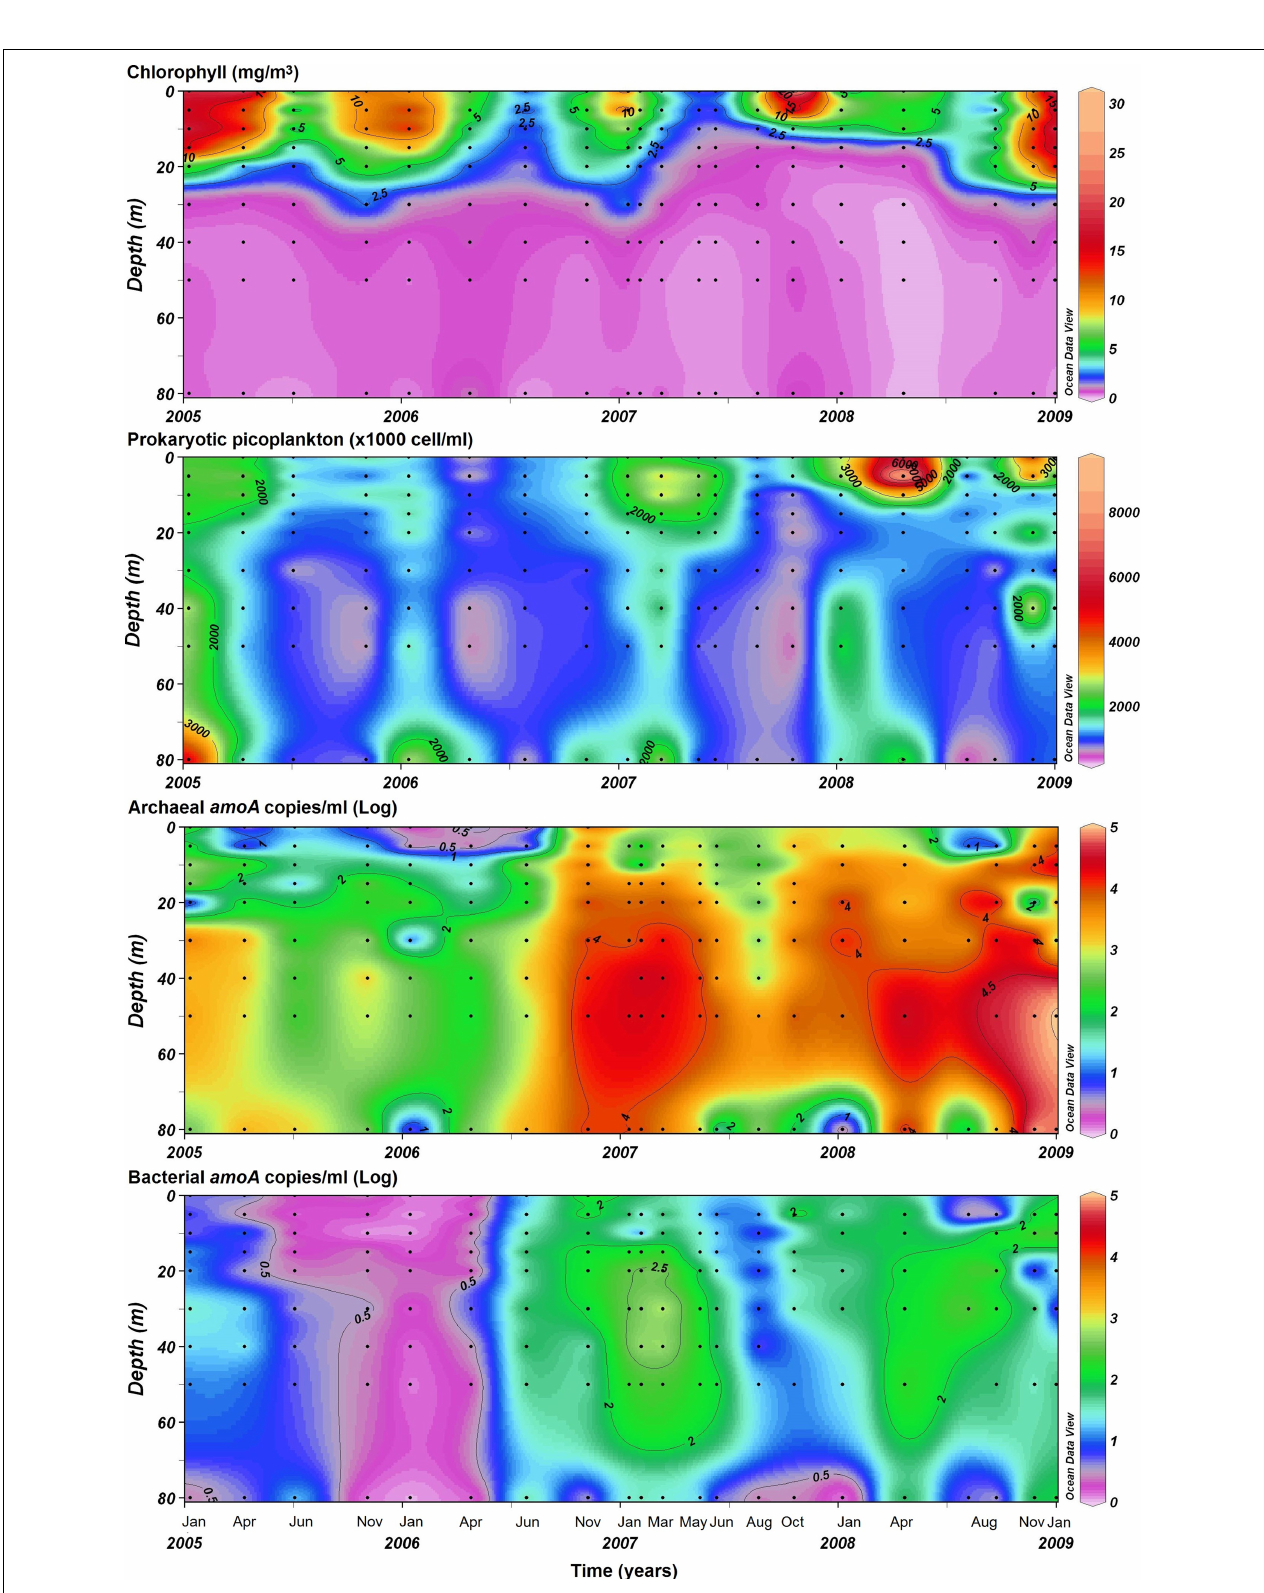
FIGURE 2 | Spatiotemporal variability of chlorophyll concentration, non-photosynthetic picoplankton abundance, and amoA gene counts for general AOA and bAOB at the time series station (St.18). Dots indicate specific date and depth samplings.